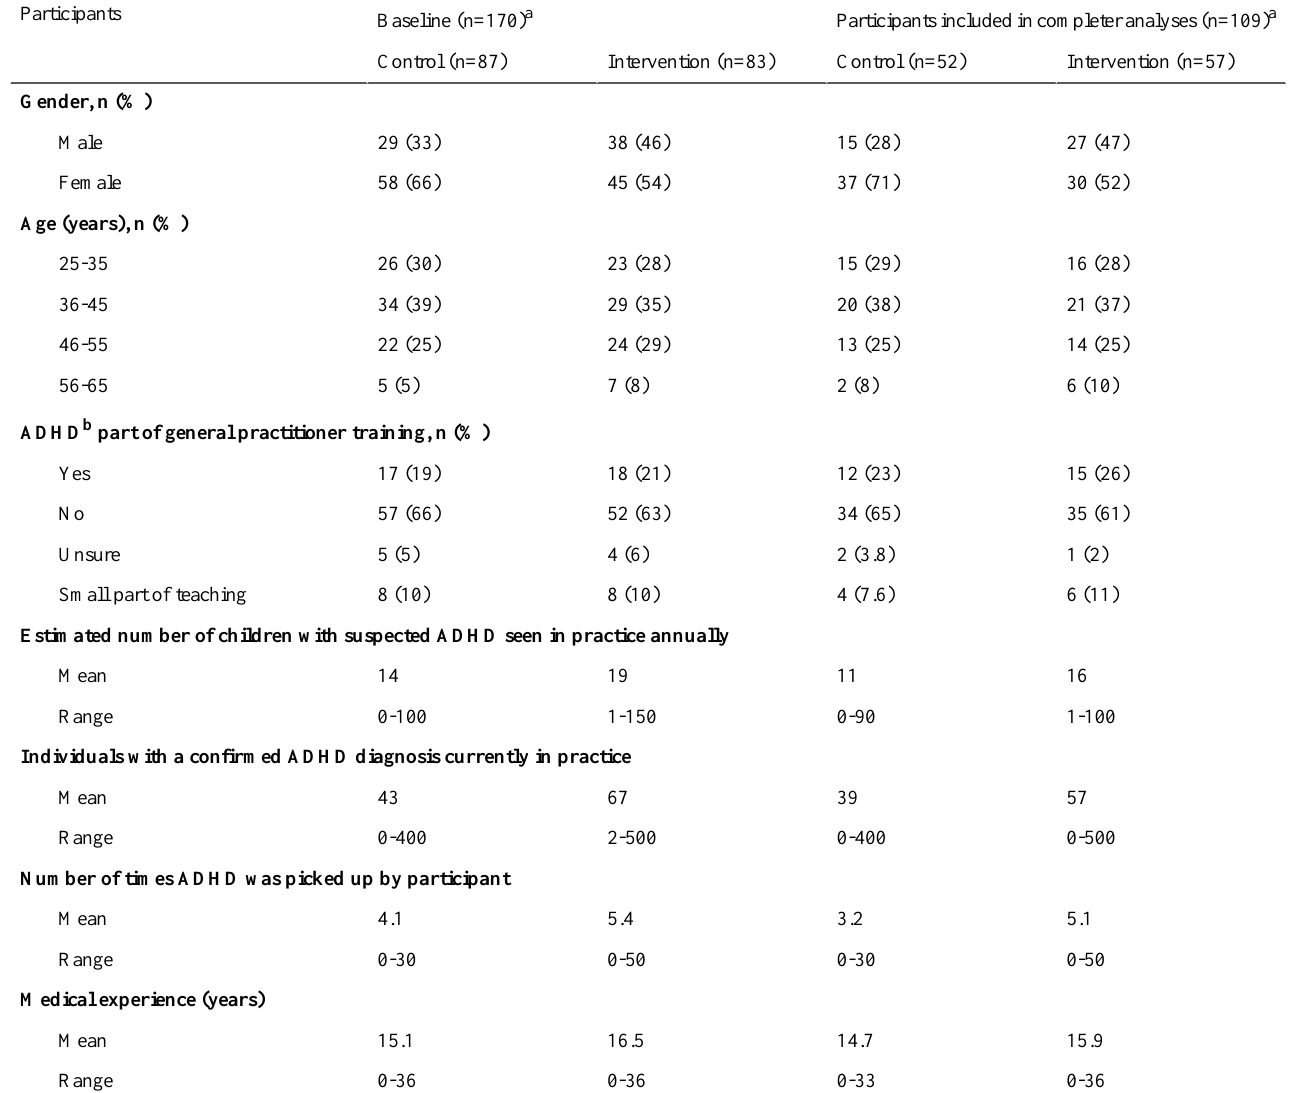
Table 1. Baseline